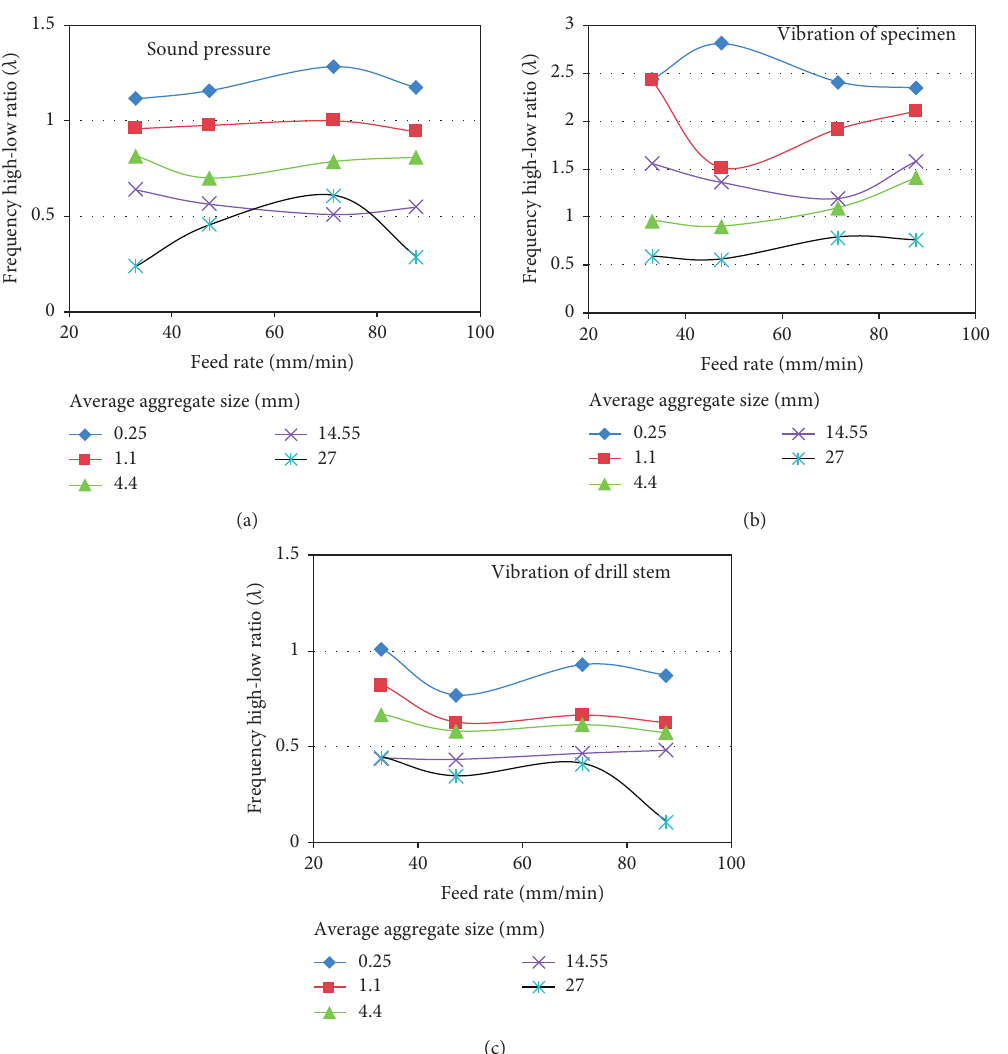
Figure 13: Frequency high-low ratio patterns of sound and vibration for different aggregate